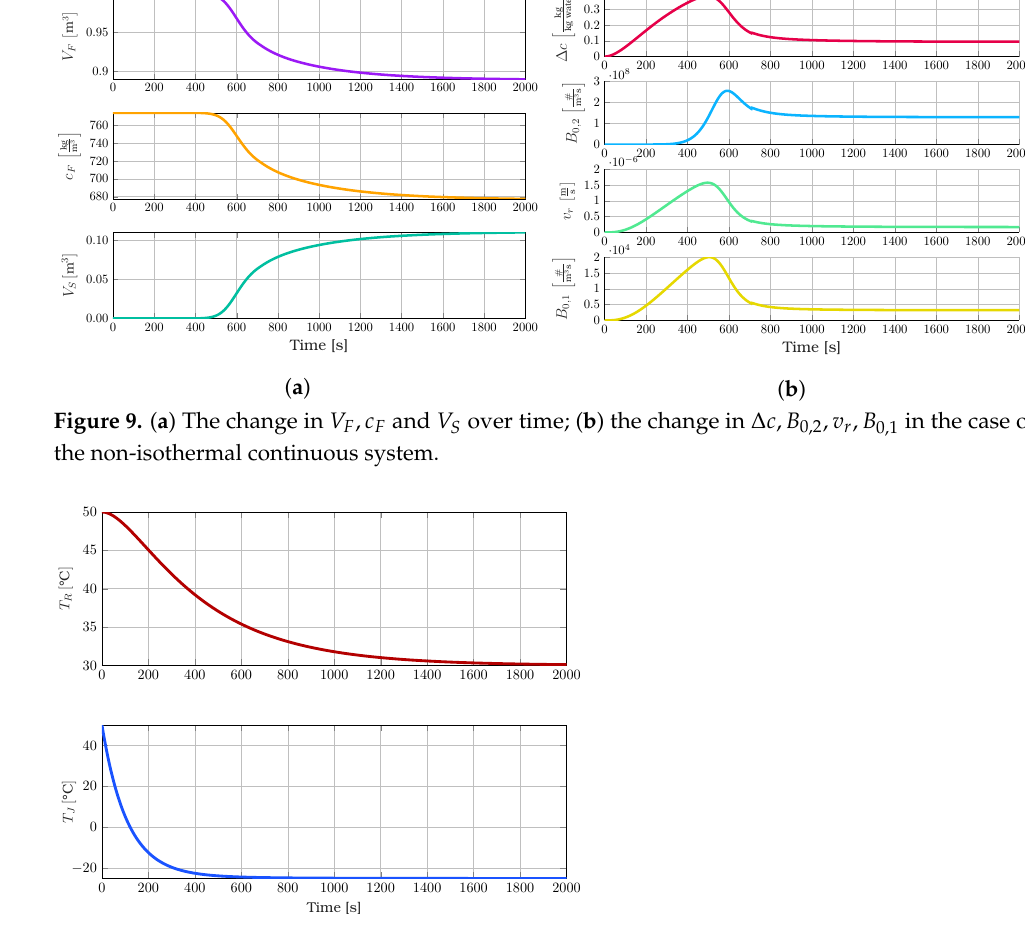
Figure 10. The change in the jacket ( T J ) and the reactor temperature ( T R ) over time in the case of the non-isothermal continuous